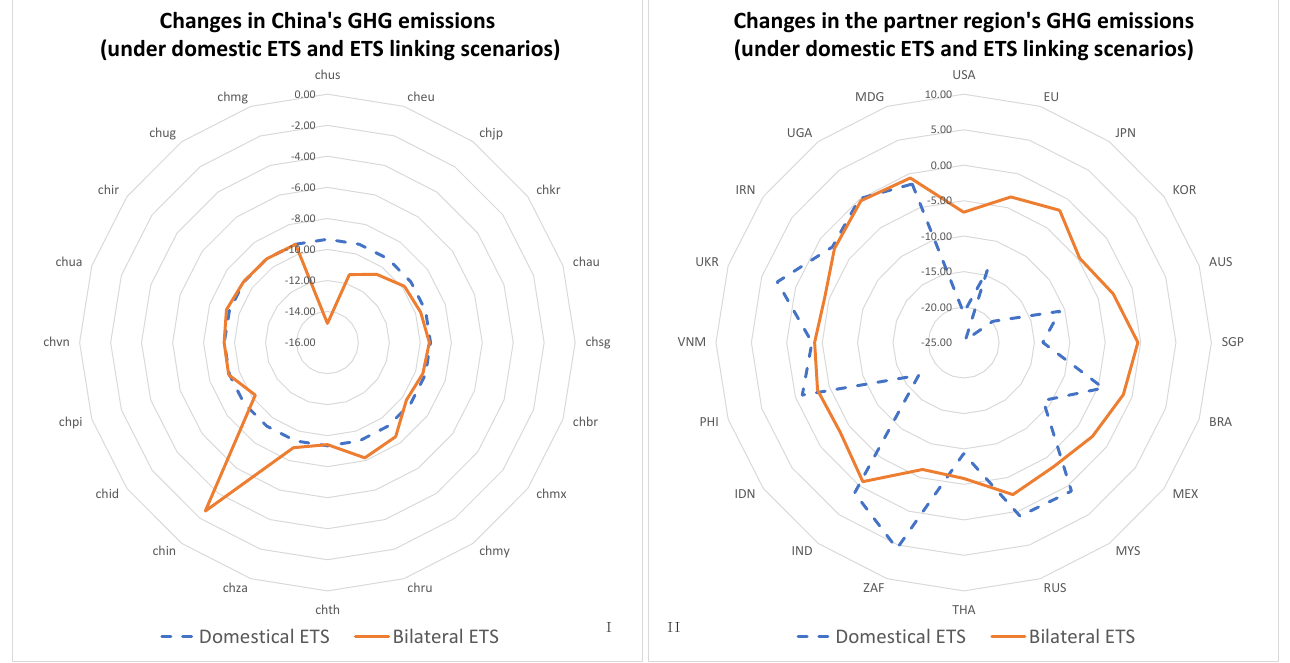
Figure 3. Changes in the greenhouse gas emissions of the different regions. ( I , II ), under domestic ETS and ETS linking scenarios, greenhouse gas (GHG) emissions change in China ( I ) and the partner regions ( II ).